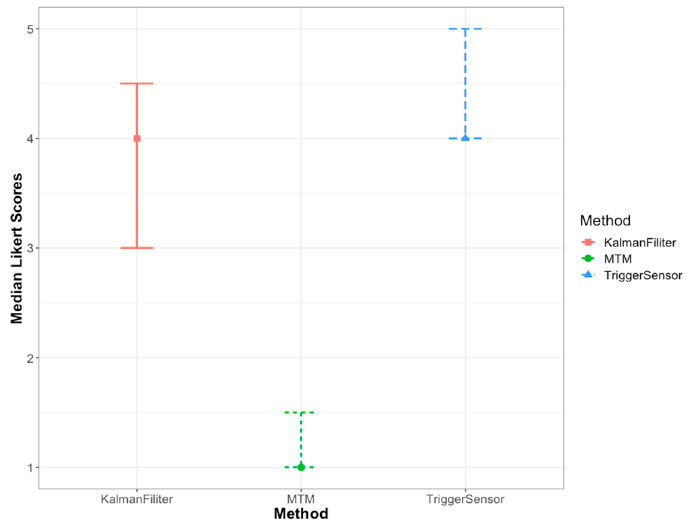
Figure 14. Median preference score for the three handover prediction models.